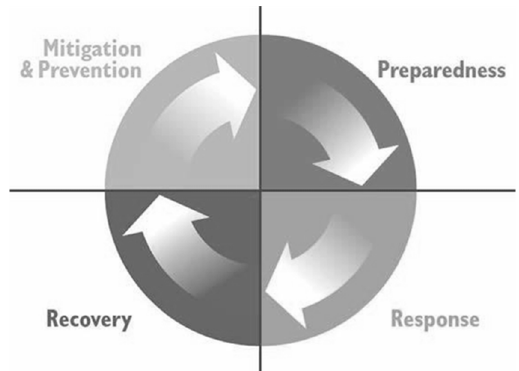
Figure 1. An example of the disaster management cycle [42].